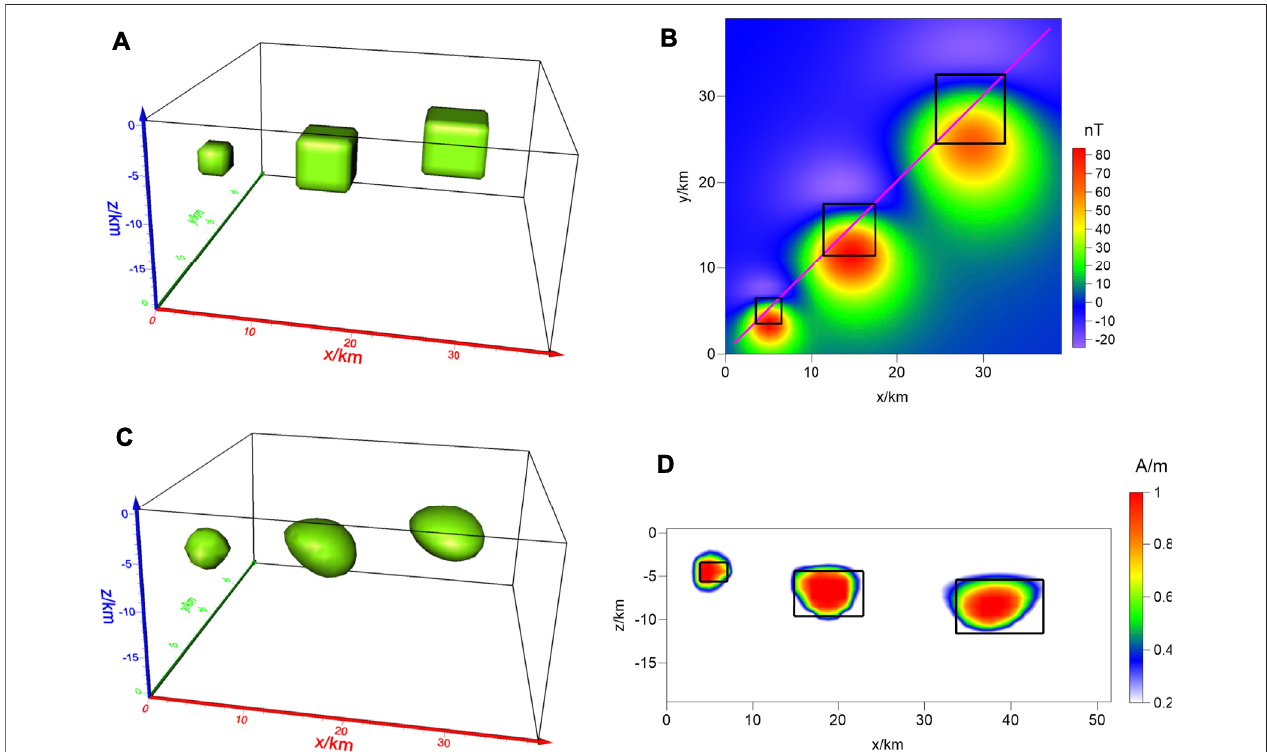
FIGURE 3 | Theoretical Magnetization model of three-blocks model: (A) True model; (B) The oblique magnetic anomaly at an inclination of 52 ° and declination of – 1 ° (theblackboxesindicatethetruepositionsoftheabnormalbody,thepinklineindicatesthepro fi le); (C) theiso-surfaceofMagnetizationinversionresult(M (cid:2) 0.5A/m); (D) the pro fi le of the inversion result (the black boxes indicate the true positions of the abnormal body).